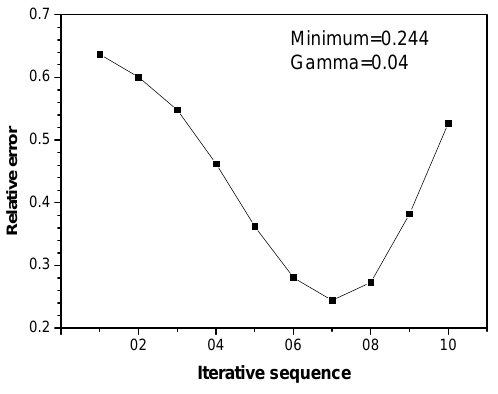
Fig. 9. Relative error variance during an iteration for which γ =0.04.